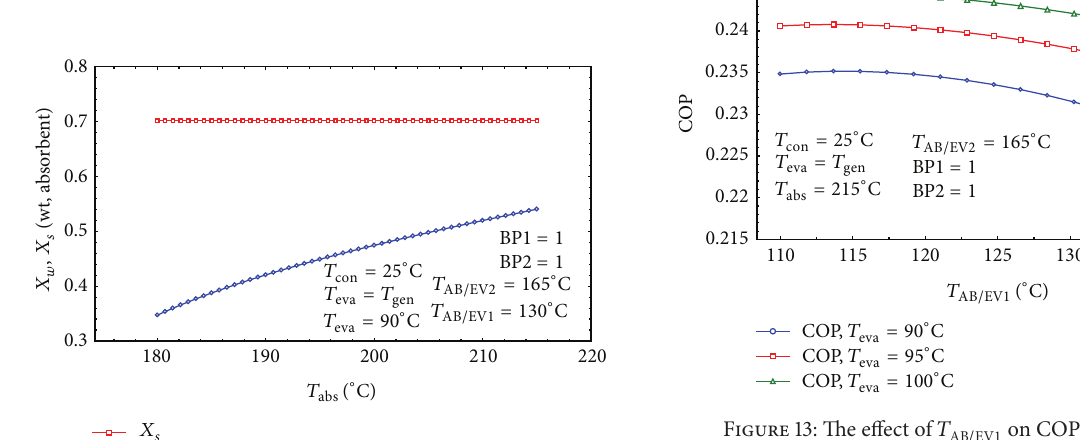
on the concentration of the strong and abs